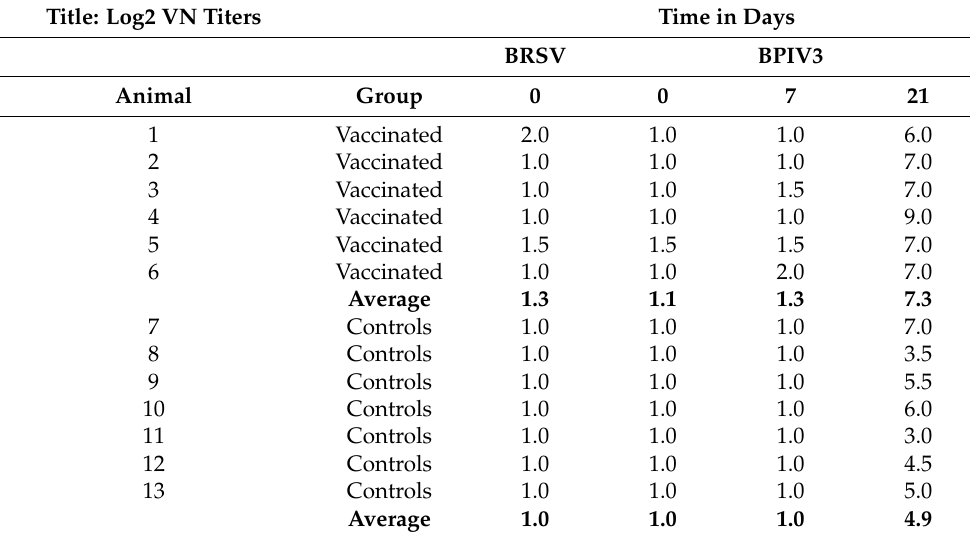
Table 1. Serological response in VN titers against BRSV and BPIV3.